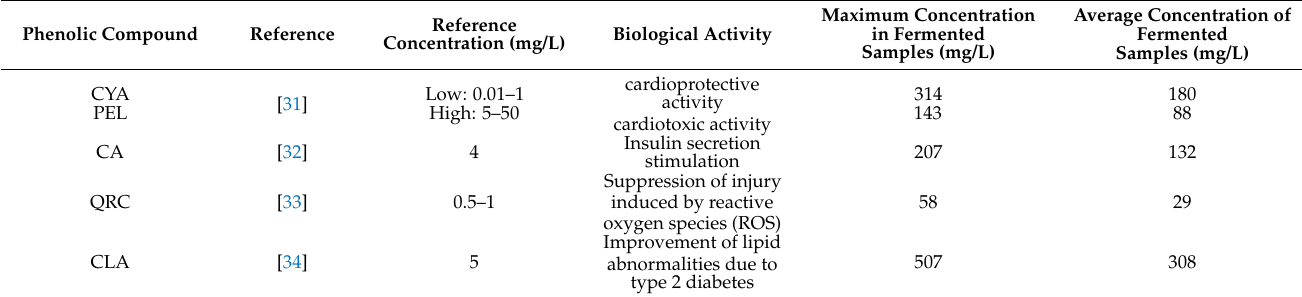
Table 2. Comparison of the extractions obtained in samples from the fermented samples of other authors and their biological